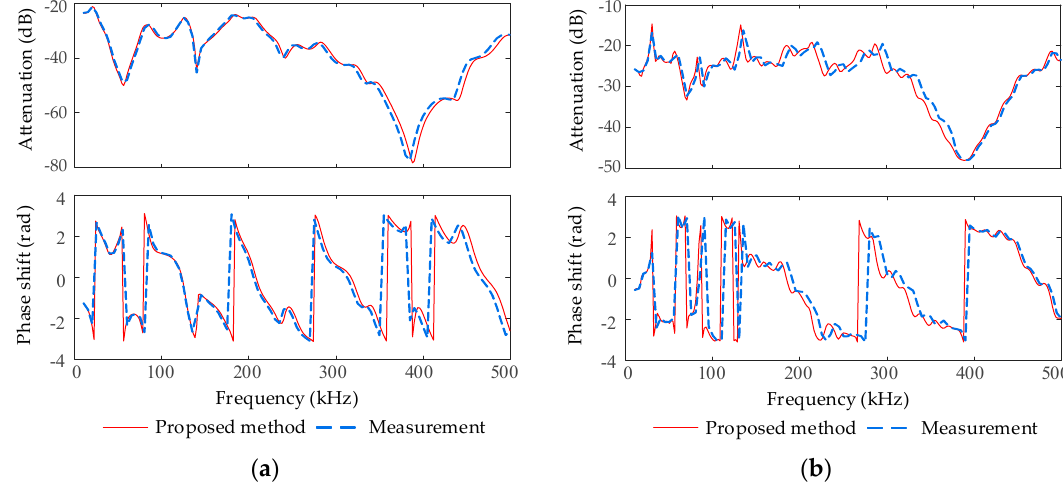
Figure 9. Frequency response characteristics of the ring distribution network under different operation modes: ( a ) The open loop mode and ( b ) the closed loop mode.